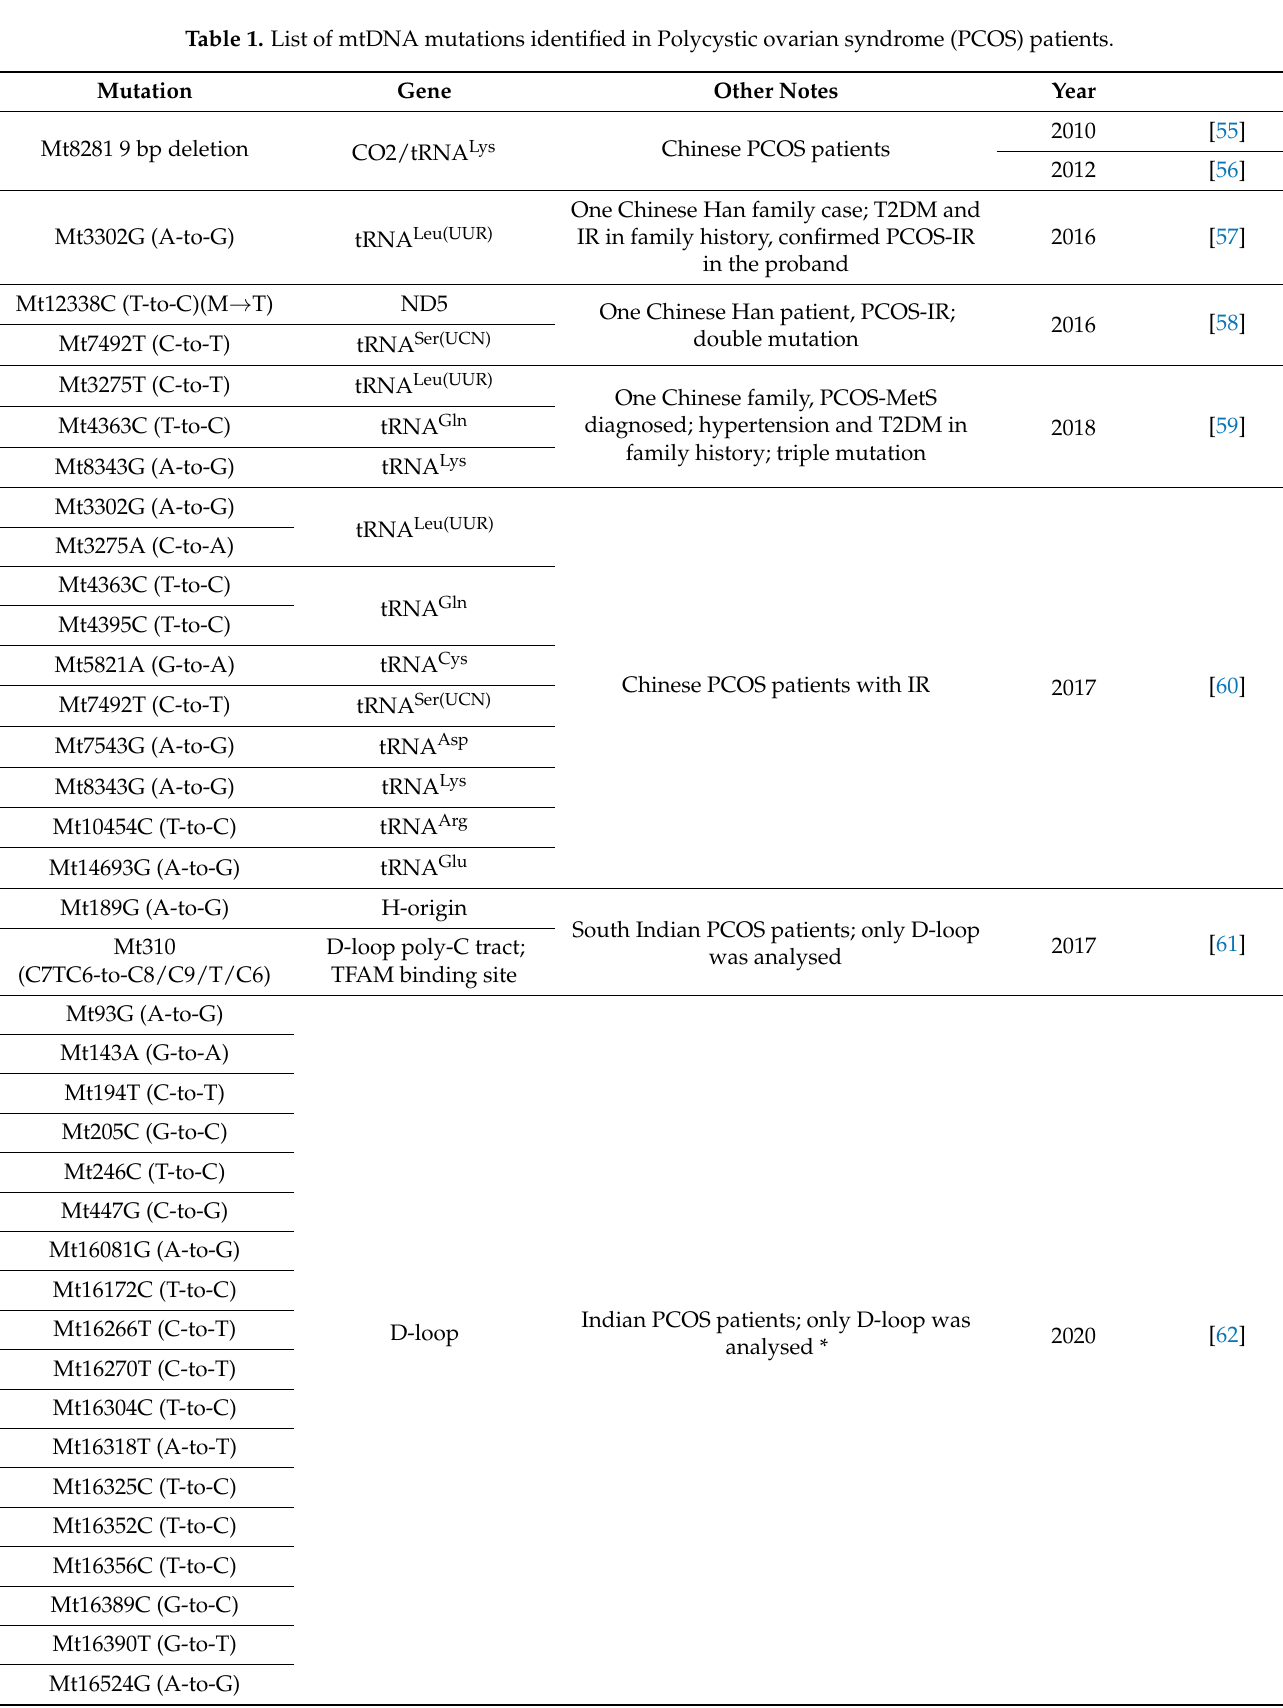
Table 1. List of mtDNA mutations identified in Polycystic ovarian syndrome (PCOS)